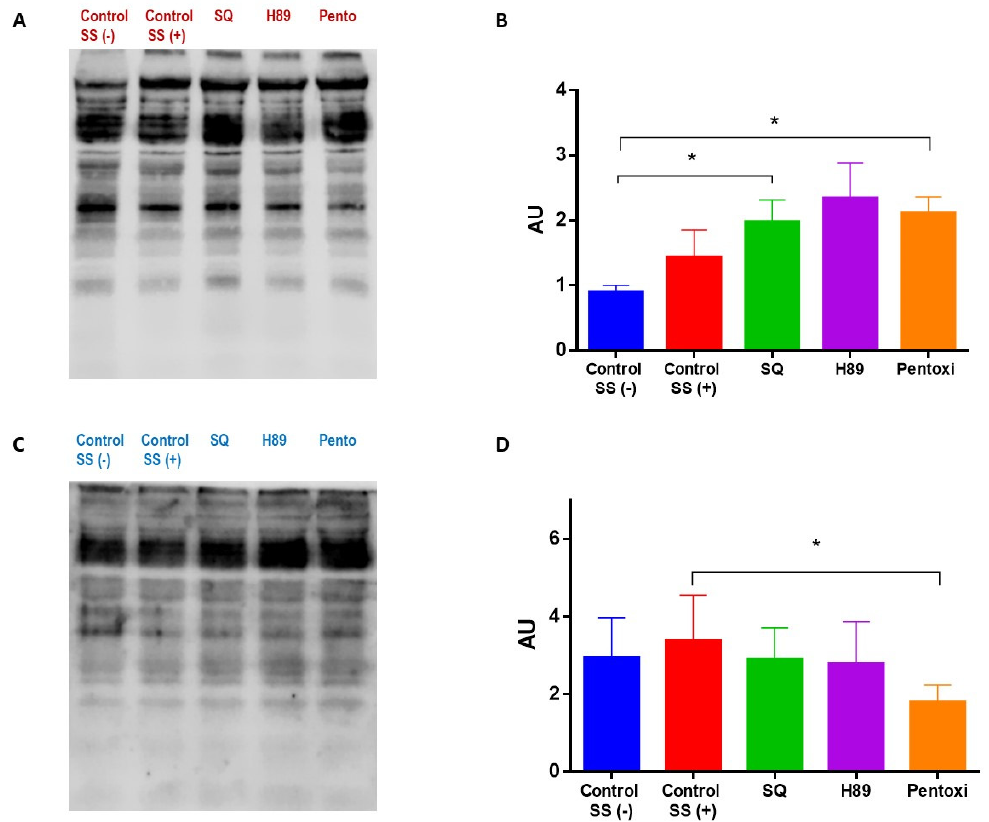
Figure 5. The changes in the phosphorylation of RBC membrane proteins due to different treatments. Phosphorylation at tyrosine and serine residues of cytoskeletal proteins are depicted in panels ( A , B ) and ( C , D ), respectively. Panels ( A , C ) are representative images. Data are represented as means ± SD, n = 10, * p < 0.05.